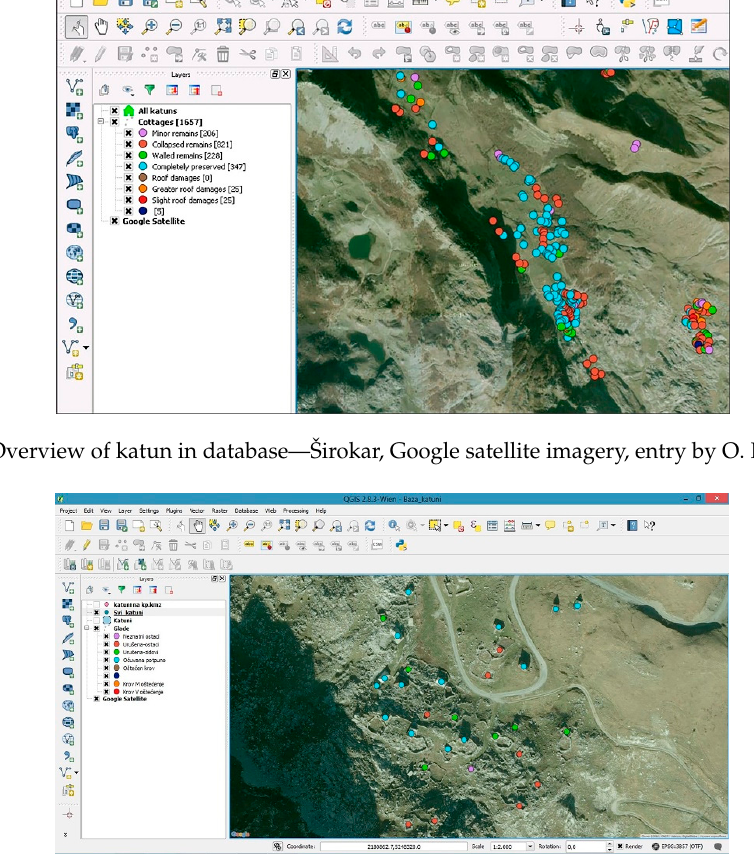
Figure 3. Snapshot from database - katun Ljakovi ć a, entry by O. Pelcer-Vuja č i ć .